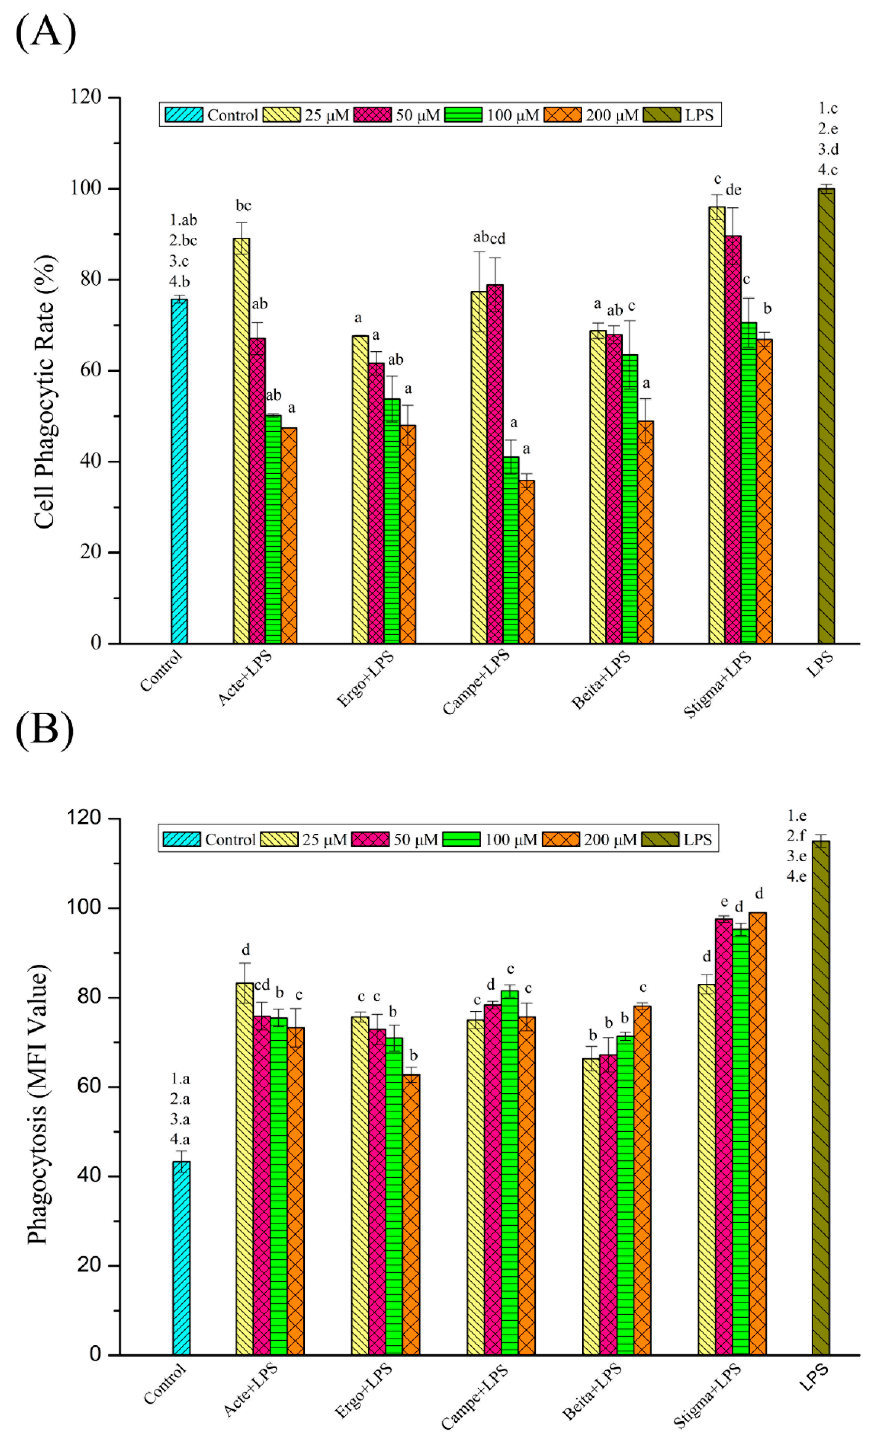
Figure 3. ( A ) E ff ects of phytosterols on the phagocytic e ff ect of LPS-stimulated RAW264.7 macrophages Figure 3. ( A ) Effects of phytosterols on the phagocytic effect of LPS-stimulated RAW264.7 detected by neutral red method ( n = 6). ( B ) E ff ects of phytosterols on LPS-stimulated inflammatory cell macrophages detected by neutral red method ( n = 6). ( B ) Effects of phytosterols on LPS-stimulated inflammatory cell model phagocytosis of fluorescein isothiocyanate (FITC)-dextran ( n = 6). Acte model phagocytosis of fluorescein isothiocyanate (FITC)-dextran ( n = 6). Acte (ergosterol acetate); Ergo (ergosterol acetate); Ergo (ergosterol); Campe (campesterol); Beita ( β -sitosterol); Stigma (ergosterol); Campe (campesterol); Beita ( β -sitosterol); Stigma (stigmasterol). The data are expressed as means ± SEM; di ff erent superscript letters for columns at the same concentration denote a significant di ff erence ( p < 0.05); the numbers describe that the control / model group was compared with the experimental group at the concentrations of 25 (1), 50 (2), 100 (3), and 200 (4) µ